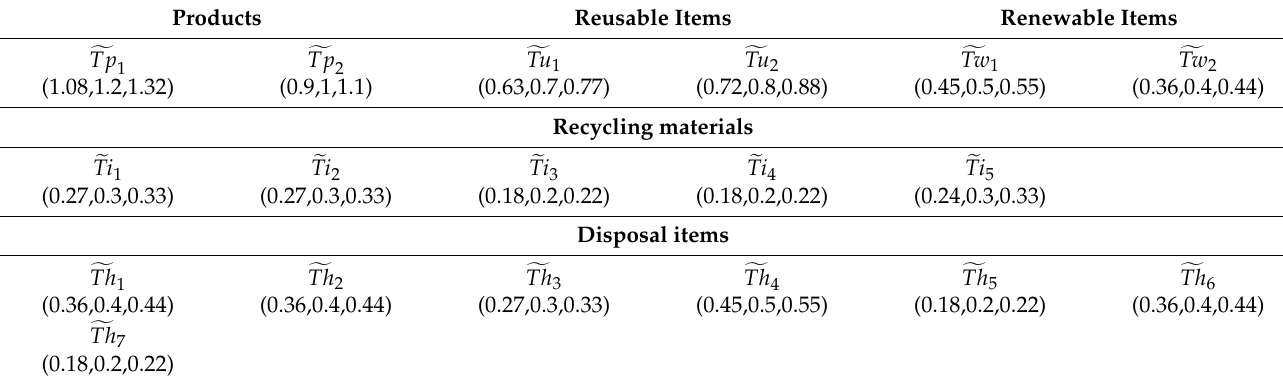
Table 7. The unit transportation cost (us